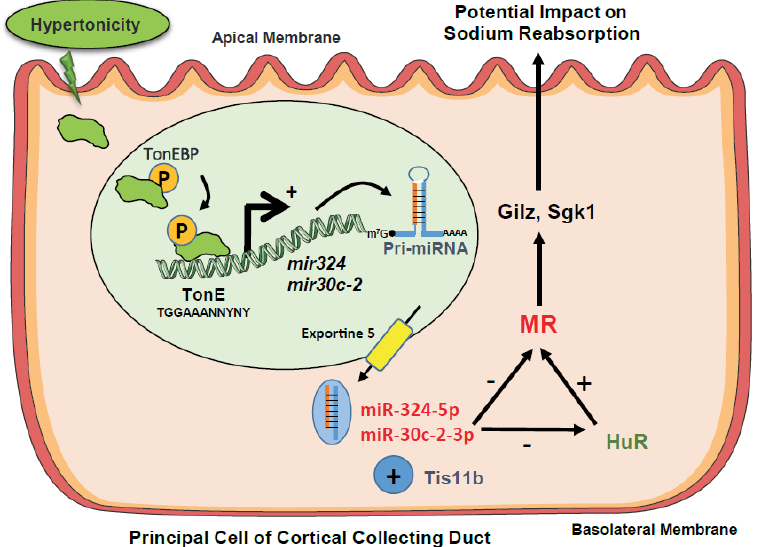
Figure 8. Proposed model for the post-transcriptional control of renal MR expression by miRNAs under hypertonicity and its impact on MR signaling. Under hypertonicity, the transcription factor TonEBP binds TonE elements located in the regulatory regions of mir324 and mir30c-2 genes which encode miR-324-5p and miR-30c-2-3p, respectively. Hypertonicity stimulates transcription of pri- miRNAs of miR-324-5p and of miR-30c-2-3p and their maturation. Thereafter, these miRNAs can repress MR expression directly by interacting with Nr3c2 (MR) 3′ -UTR or indirectly by interacting with Elavl1 (HuR), an RNA Binding Protein, which was shown to stabilize Nr3c2 (MR) transcript under hypotonicity [19]. Moreover, these miRNAs can cooperate with Tis11b, an RNA Binding Protein, which was previously shown to accelerate destabilization of MR transcripts [18]. Thus, hypertonicity may compromise MR